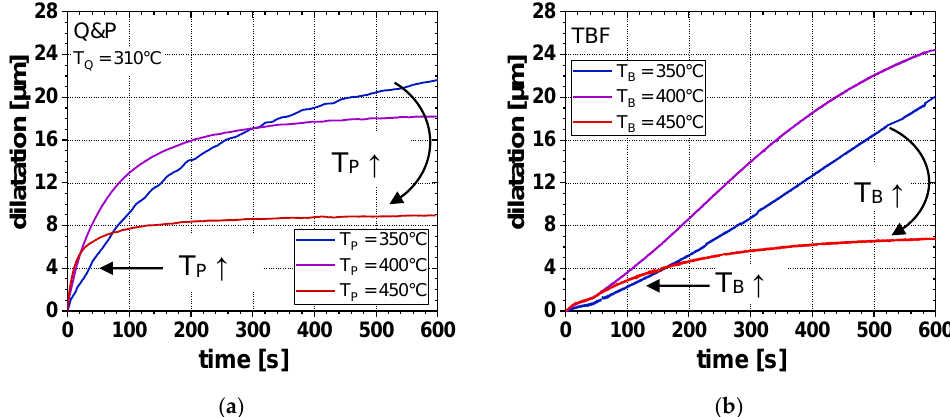
Figure 4. Dilatation due to α B formation as a function of isothermal holding time at different T P ( T B ) for ( a ) Q&P steel ( T Q = 310 °C) and ( b ) TBF steel.